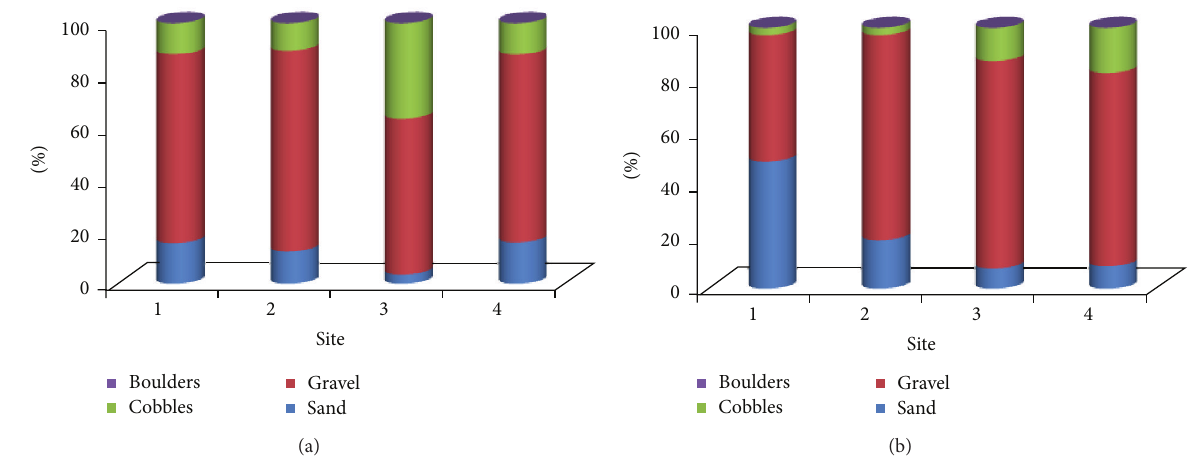
Figure 5: Proportions of clasts from volumetric